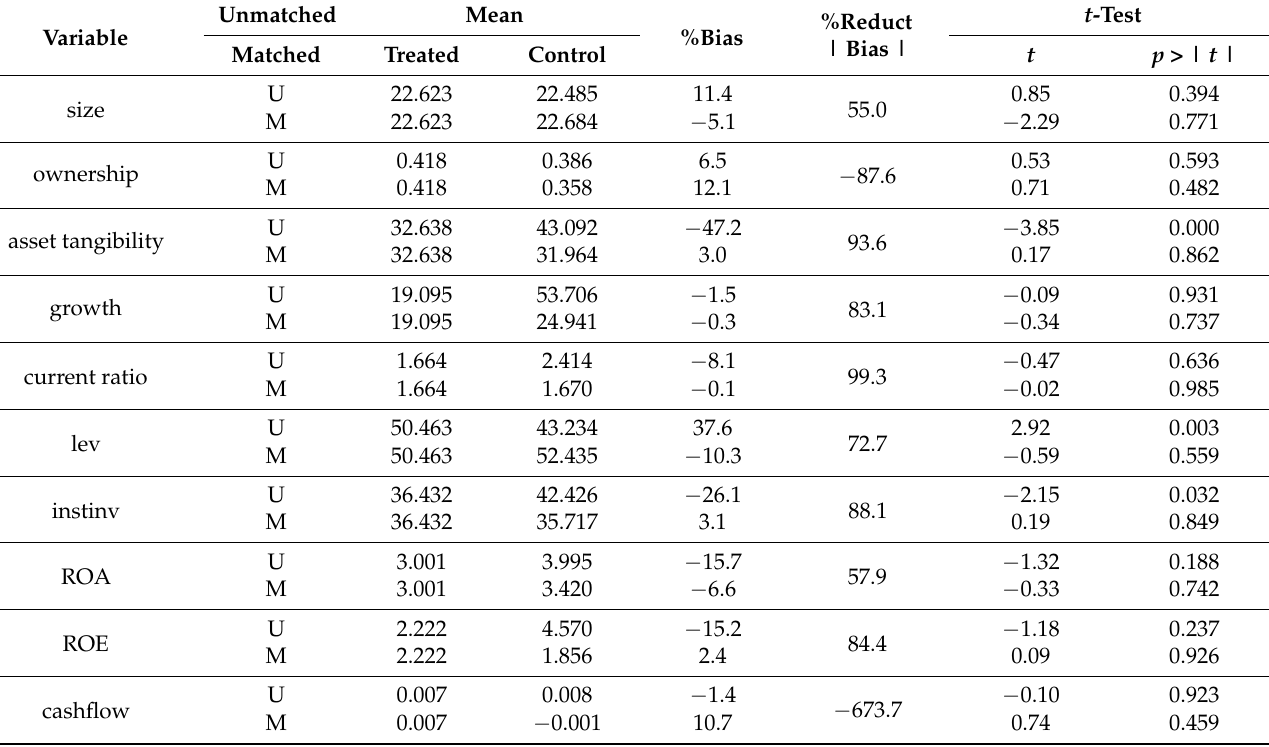
Table 2. Propensity score matching (PSM) balance test.